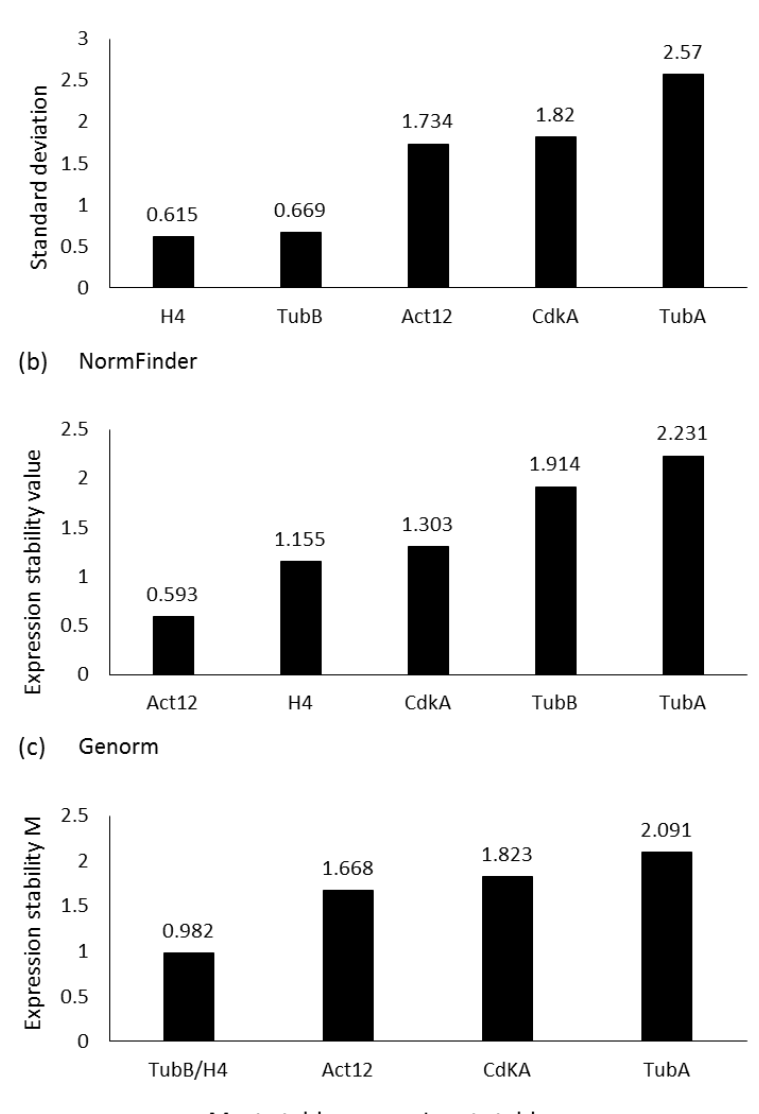
Figure 1. Reference gene assessment for P. tricornutum . Arrows indicate the most stable reference genes according to ( a ) BestKeeper (lowest standard deviation), ( b ) NormFinder (lowest expression stability value), and ( c ) geNorm (lowest average expression stability M) softwares. The selected genes were: Actin 12 (Act12), cyclin-dependent kinase (Cdk), histone 4 (H4), α -tubulin (TubA) and β -tubulin